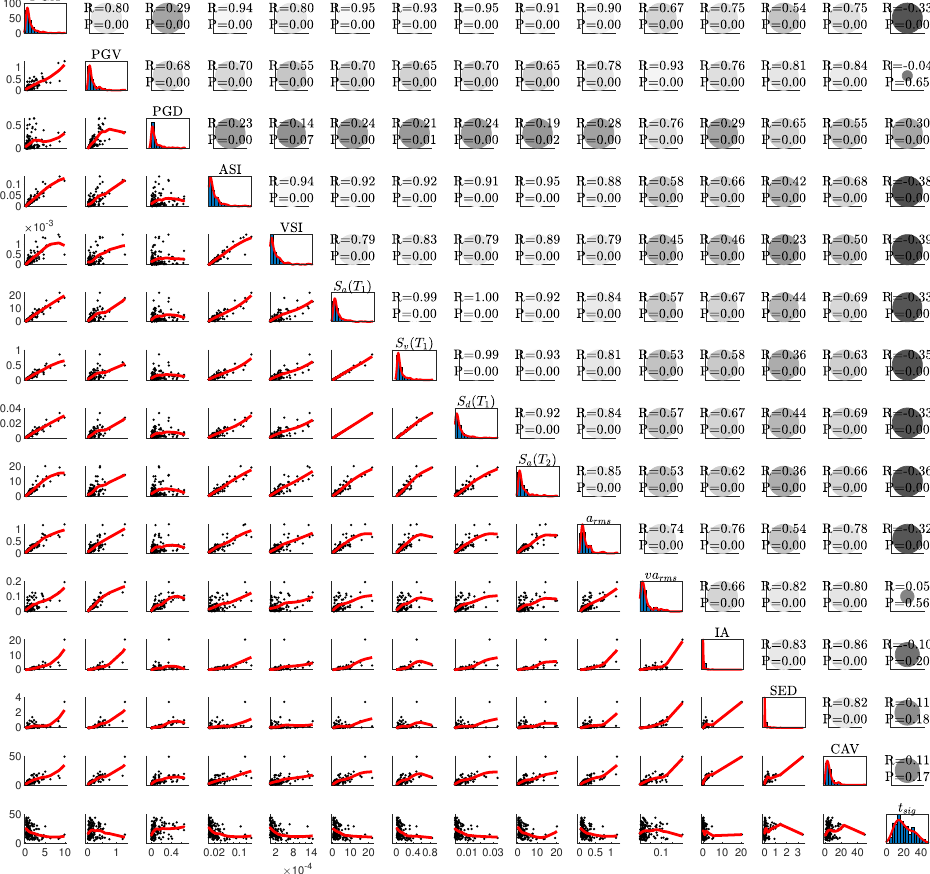
Figure 5. Matrix of fifteen seismic intensity measures for all the applied ground motion records. R: Correlation, and P: p